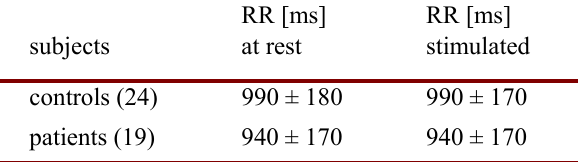
Table 1. RR-interval ± S.D. [ms] in the group of patients with Parkinson’s disease and in the group of control subjects while breathing at rest and during stimulated, deep breathing at 0.1 Hz.